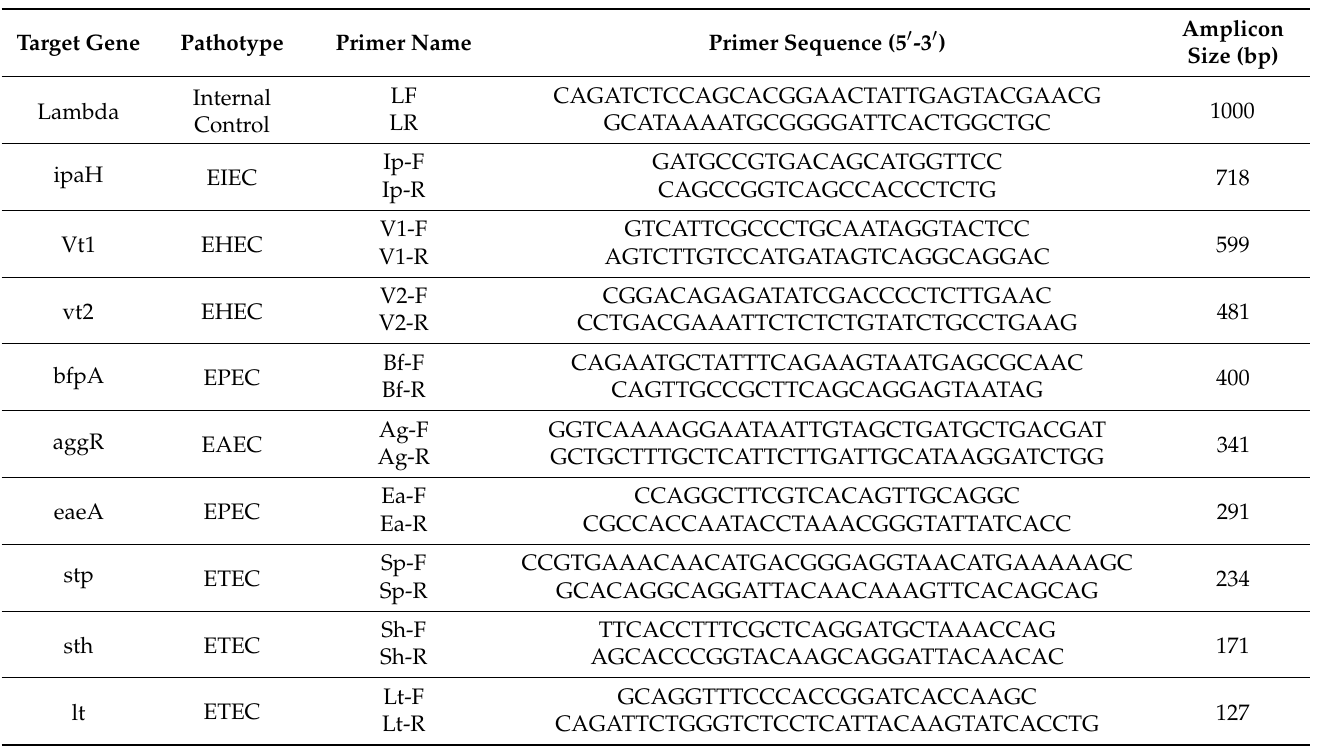
Table 1. Sequences of primers used for the detection of virulence genes in Escherichia coli isolates in the present study.